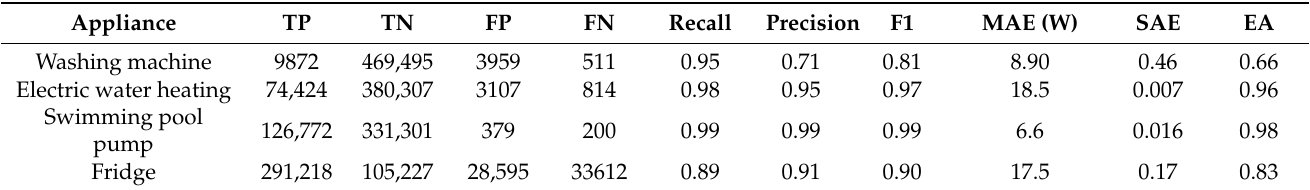
Table 5. Performance’s evaluation results without ApproxHull: mean absolute error (MAE), signal aggregate error (SAE), and estimation accuracy (EA).